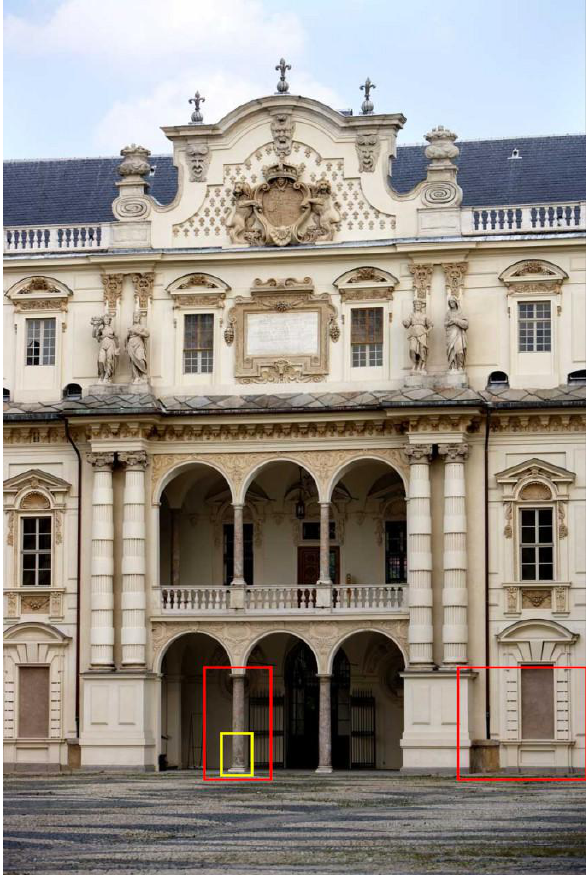
Figure 1. Castello del Valentino main (west) façade (modified from https://castellodelvalentino.polito.it). The preliminary surveys are indicated with red and the detailed surveys with yellow